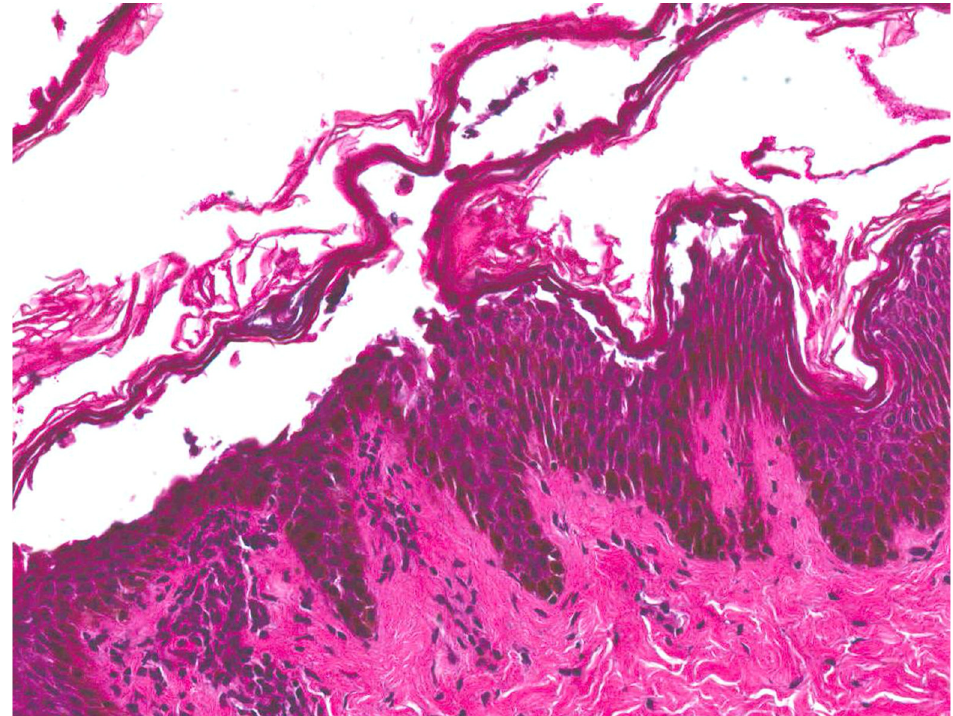
Figure 2. Staphylococcal scalded skin syndrome. Subcorneal acantholysis without inflammation, crust, or bacterial cocci (H&E, 200× magnification). Original image provided by Kiran Motaparthi, MD.